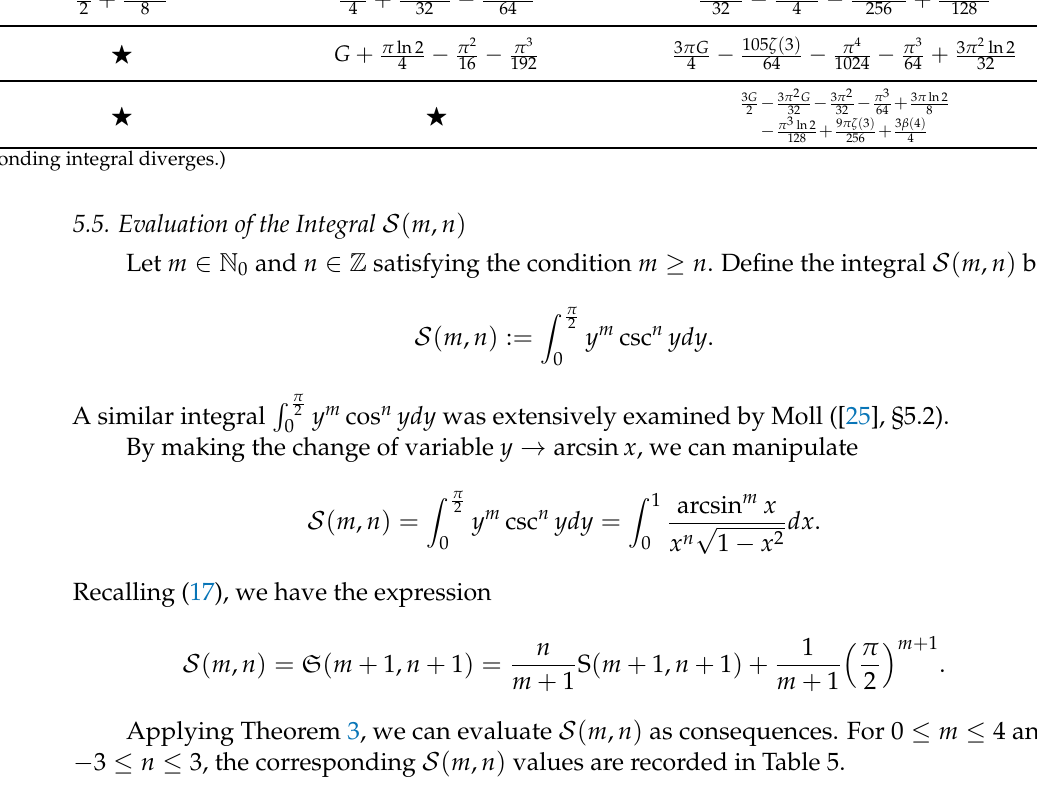
Table 5. Values for S ( m , n )